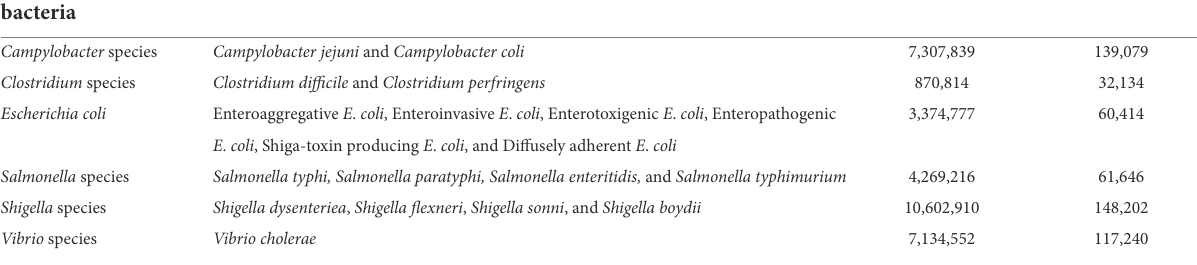
TABLE 1 Global illness and death due to Diarrheagenic bacteria complications in 2019 (IHME, 2020; Murray et al., 2020). Diarrheagenic